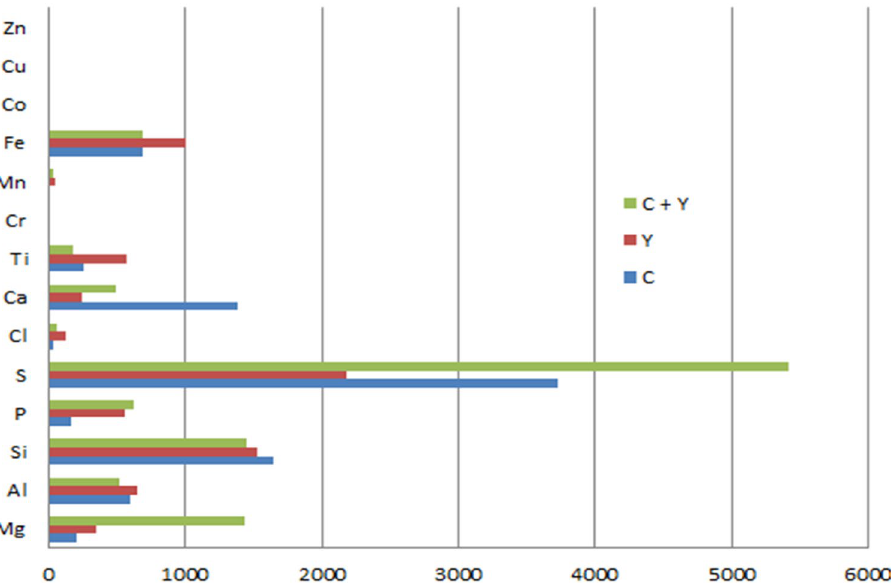
Figure 4. The average elemental composition of elements in cassava peels, yam peels, and cassava + yam peels.